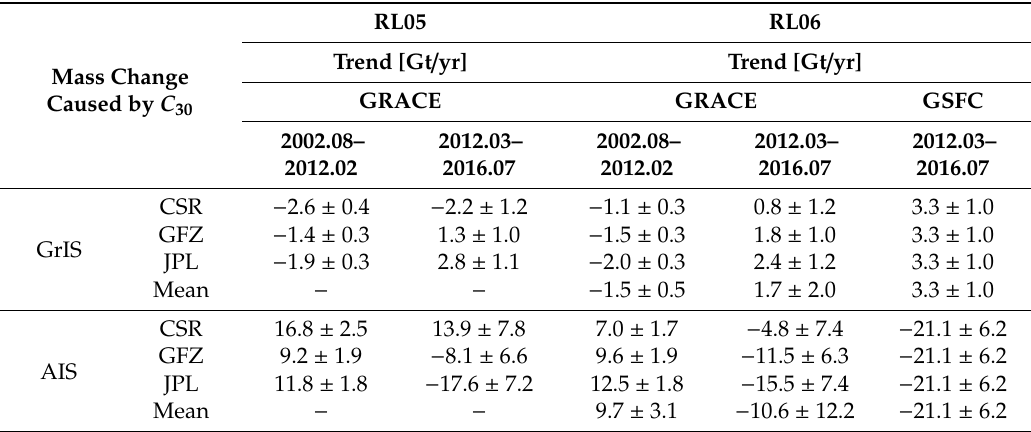
Table 4. The trends of mass change time series caused by C 30 estimates separately from GRACE RL05 / RL06 data and GSFC over the GrIS and the AIS during the period from August 2002 to February 2012, and the period from March 2012 to July 2016.